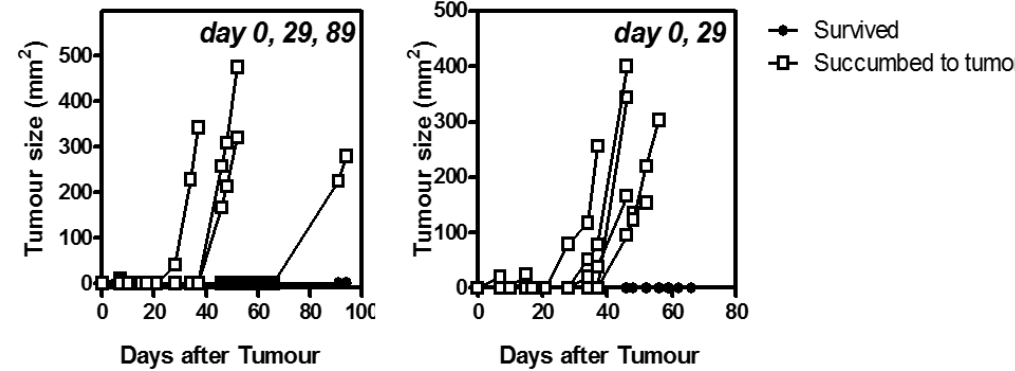
Figure A2. Tumor challenge following staggered prime-boost vaccinations with. MS-OVA. C56BL/6 mice were vaccinated by s.c. injection with 20 µg of MS-OVA in the middle of the dorsal flank at day 0, 29, and 89 as indicated in the legend. Two hundred sixteen days after initial vaccination 10 6 B16-OVA cells were injected s.c. in the lower dorsal flank. Tumor volume is measured over time. n = 3–7.